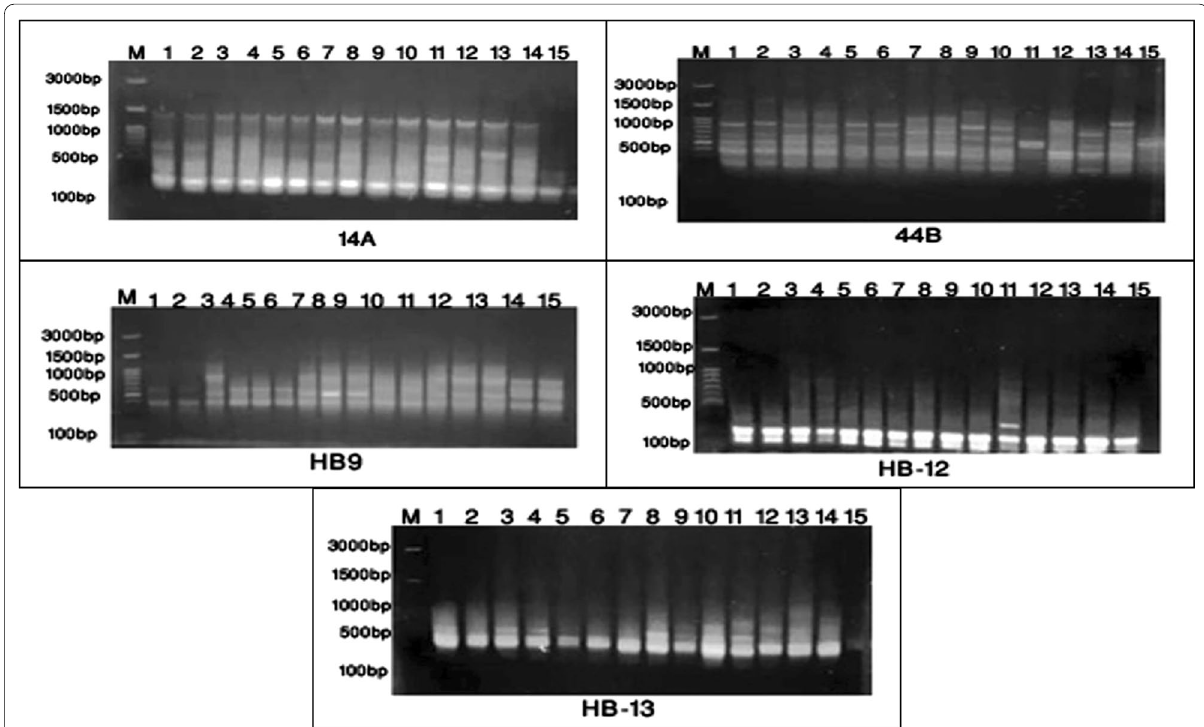
Fig. 2 Amplification profiles of the fifteen Euphorbia species with ISSR